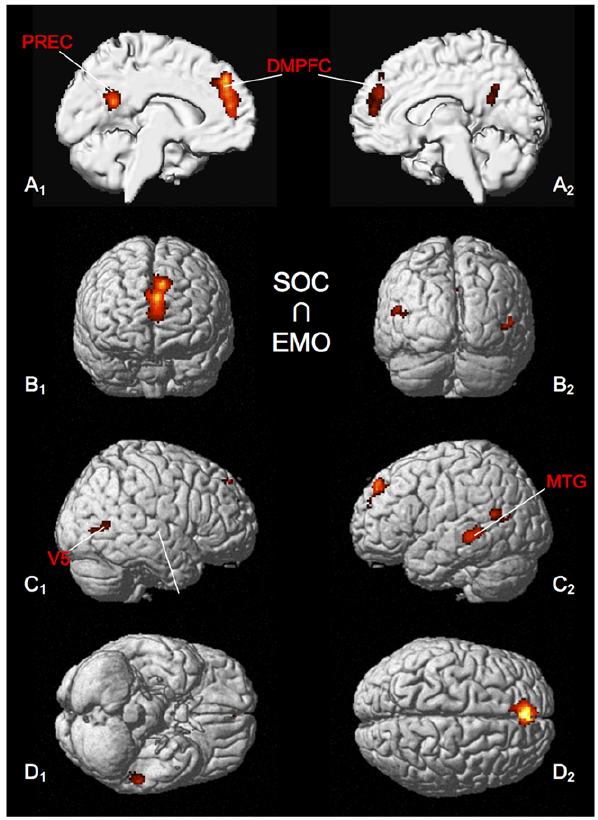
Figure 4. Significant results of the conjunction analysis of SOC > EMO. All results are displayed on the left and right lateral surface view, the anterior/posterior and dorsal/ventral view of the MNI single subject template. DMPFC: dorso-medial prefrontal cortex, PREC: precuneus, STG: superior temporal gyrus, VS: ventral striatum. doi:10.1371/journal.pone.0030920.g004 PLoS ONE |